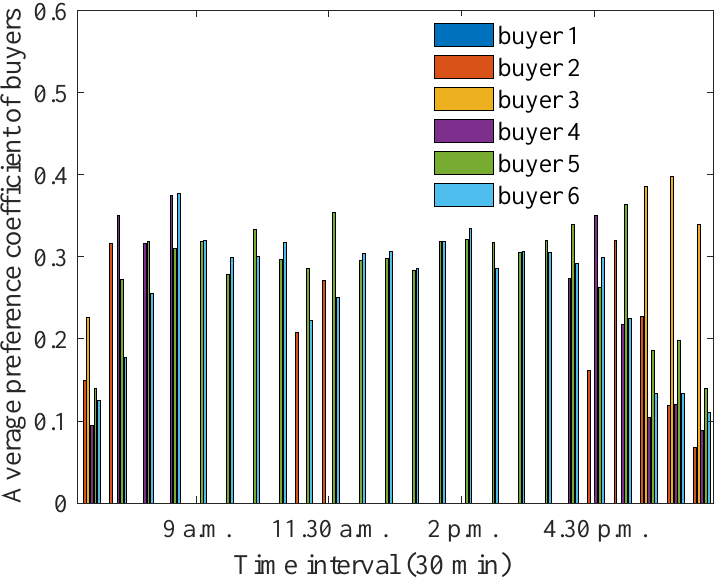
Figure 12. Optimum preference coefficients for buyers during summer